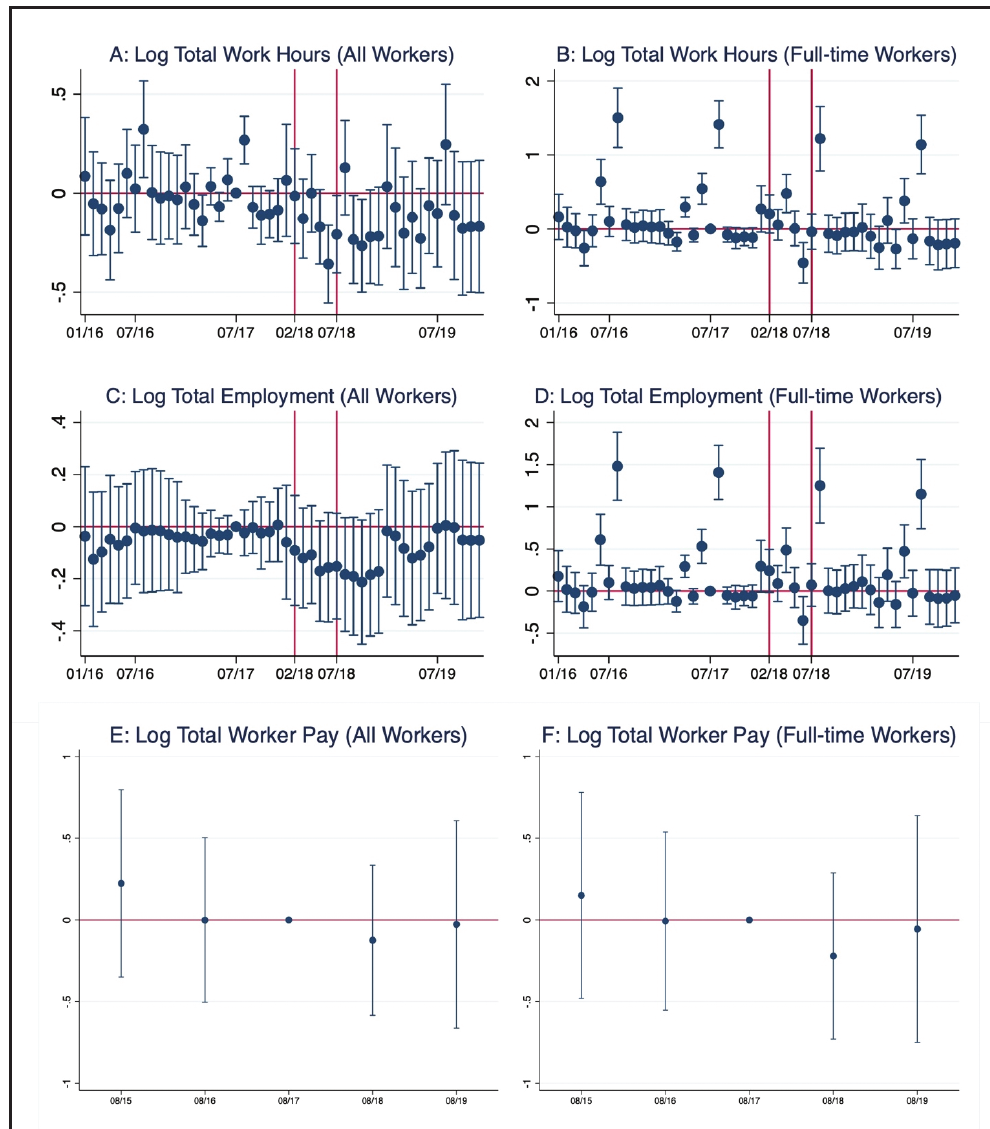
Figure 4 Group-level event-study